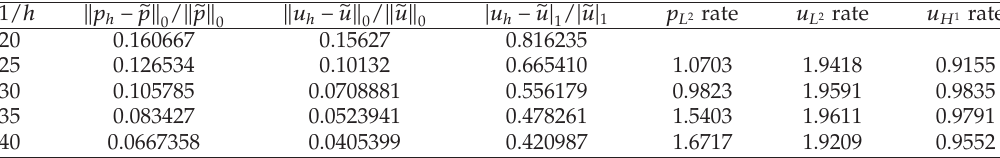
Figure 1: Uniform triangulation of Ω into triangulars. Table 1: Numerical results for enriched multiscale method with NCP 1 - P 1 element.